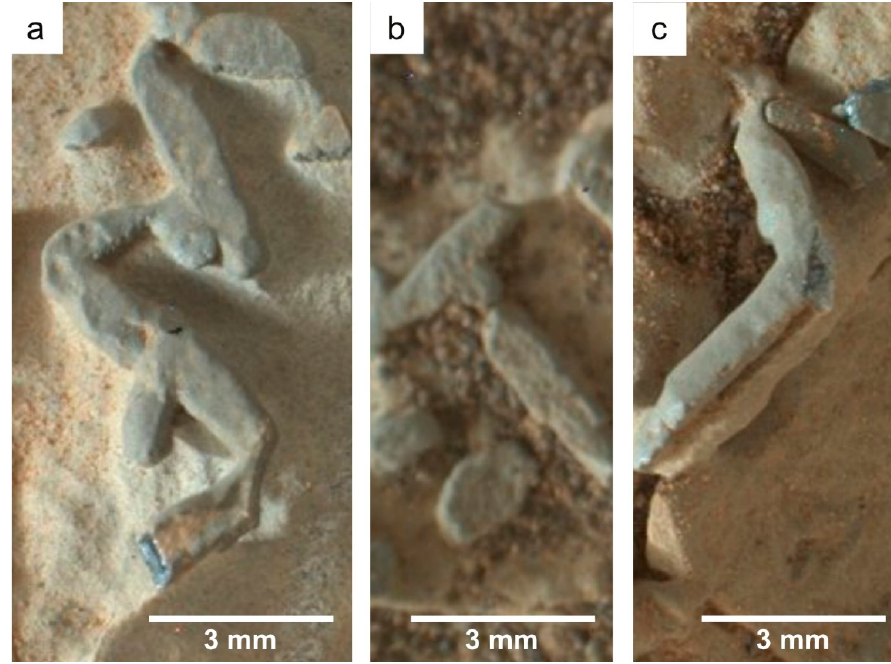
Figure 2. Stick ‐ like structures from Mars. ( a ) Stick ‐ like structure s4 intersecting the S ‐ shaped form s5, which changes its curvature at short distance from specimen s1. ( b ) T ‐ junction formed by specimens s8 and s9. ( c ) Intersection between specimens s10 and s11. See Figure 1 for specimen numbers.